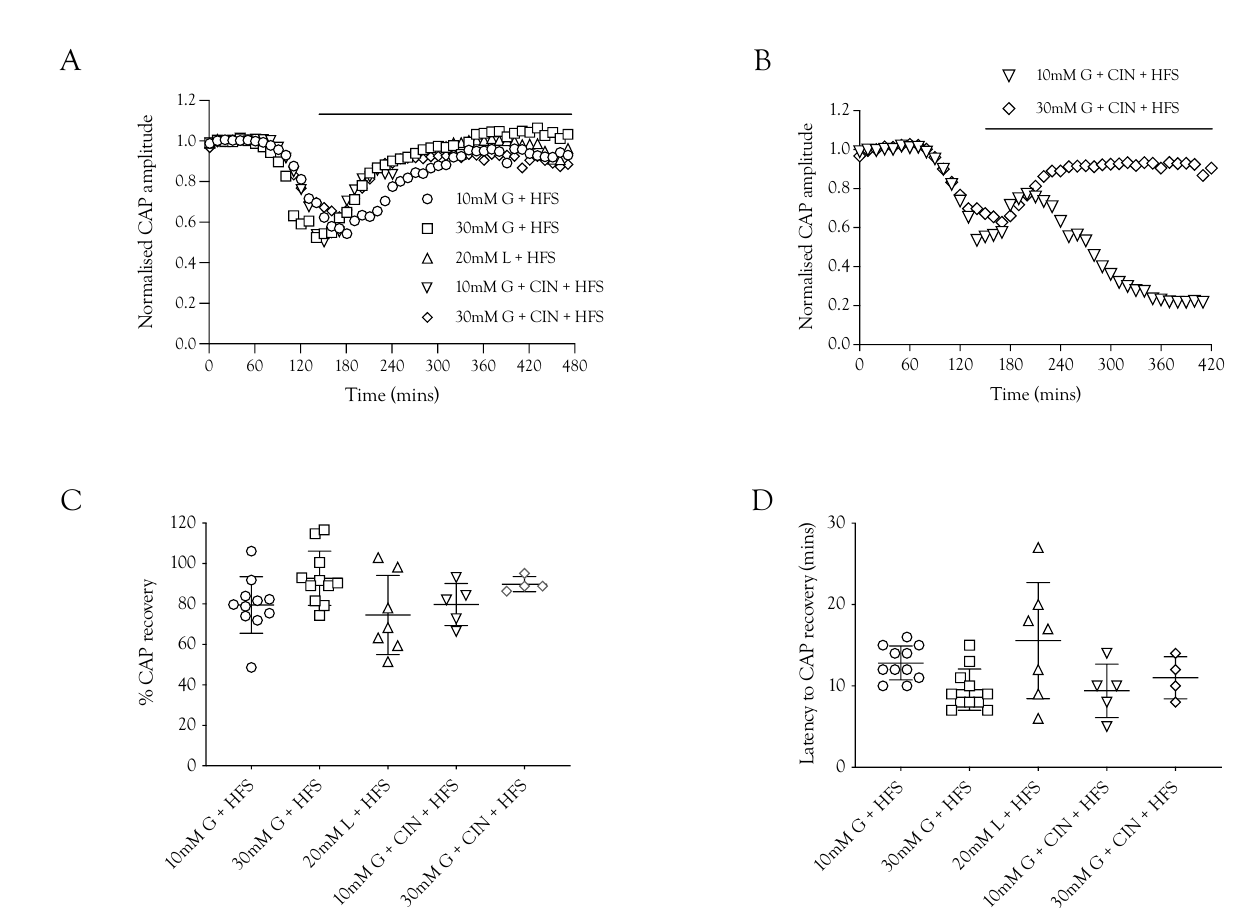
Figure 6. The A fibre CAP can be restored in the absence of glycogen. ( A ) After exposure to substrate-free conditions resulting in a drop in amplitude, the A fibre CAP was restored by glucose and lactate during HFS (indicated by the horizontal bar). ( B ) The recovery was sustained in 30 mM glucose and CIN but was only temporarily rescued in 10 mM glucose and CIN. ( C ) The A fibre CAP was restored to a similar level under all 5 conditions of HFS (79.5 ± 14.0%, n = 11 (10 mM glucose) vs. 92.7 ± 13.4%, n = 11 (30 mM glucose), 74.5 ± 19.6%, n = 7 (20 mM lactate), 79.7 ± 10.4%, n = 5 (10 mM glucose and 200 μ M CIN), and 89.8 ± 3.7%, n = 4 (30 mM glucose and 200 μ M CIN). ( D ) The time in which the A fibre CAP starts to recover during HFS after the onset of energy substrate supply was equal amongst all 5 conditions (12.8 ± 2.1 min, n = 11 (10 mM glucose) vs. 9.5 ± 2.5 min, n = 11 (30 mM glucose), 15.6 ± 7.1 min, n = 7 (20 mM lactate), 9.4 ± 3.3 min, n = 5 (10 mM glucose and 200 μ M CIN), and 11.0 ± 2.6 min, n = 4 (30 mM glucose and 200 μ M CIN).